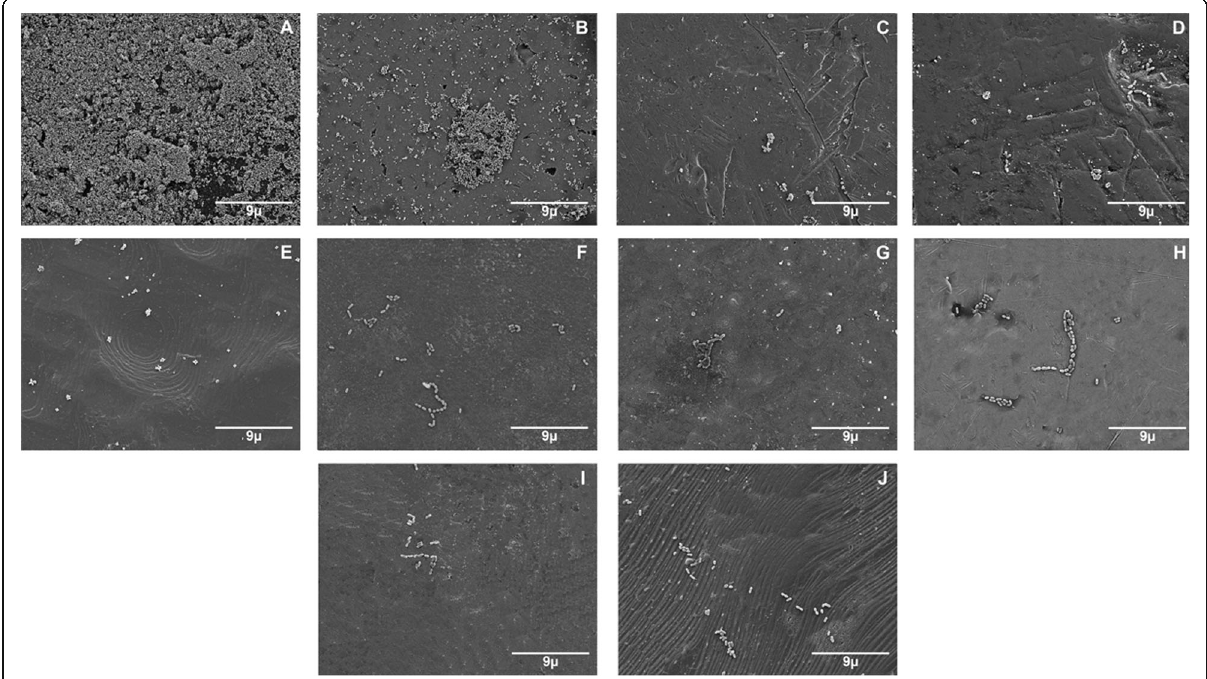
Fig. 1 Representative images from SEM of orthodontic brackets exposed to S.mutans (×2500). a GIn. b GIIn. c GIIIn. d GIVn. e GVn. f GVI. g GVII. h GVIII. i GIX. j